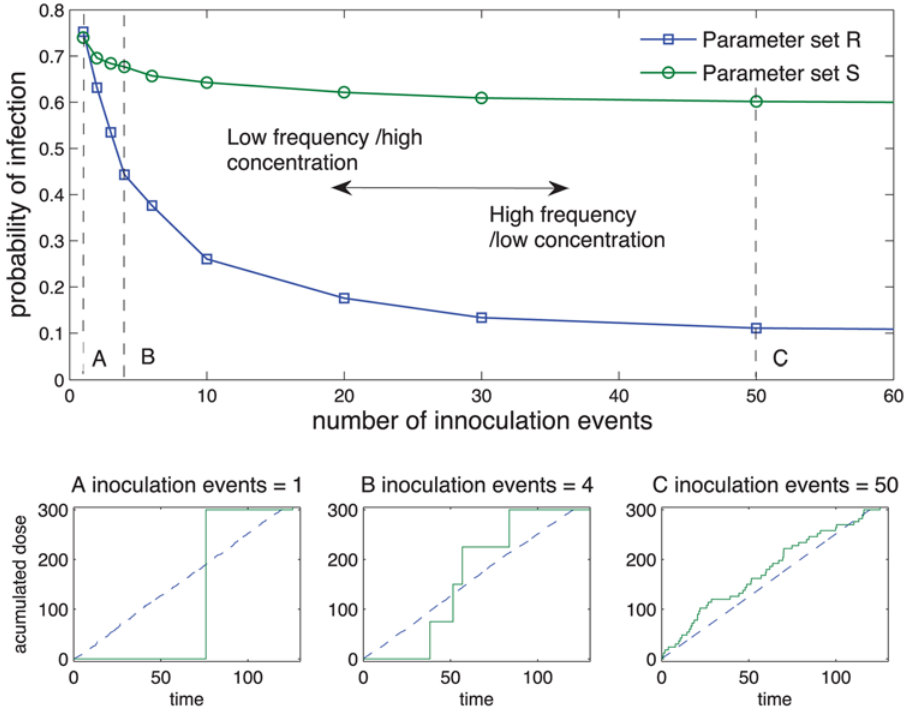
Figure 9. Predicted effects of different temporal patterns of exposure when inoculated with Cryptosporidiumparvum. The main figure displays the probability of infection as function of the number of inoculation events. The line with circular markers comes from simulation results using the parameter set defined in Figure 5, and the line with square markers comes from simulation results using the parameter set R ~ h P , d P , a I , c I , d I , l I f g ~ 4 : 4901, 2 : 2761, 7 : 490, 1 : 2570, 0 : 4241, 0 : 7871 f g The insets below demonstrate three temporal patterns for three different patterns of inoculation events: A=1, B=4 and C=50 events respectively. The solid line represents one instance of the 5000 replicas used in the experiment. The dashed line represents the average of dose inoculated over time.